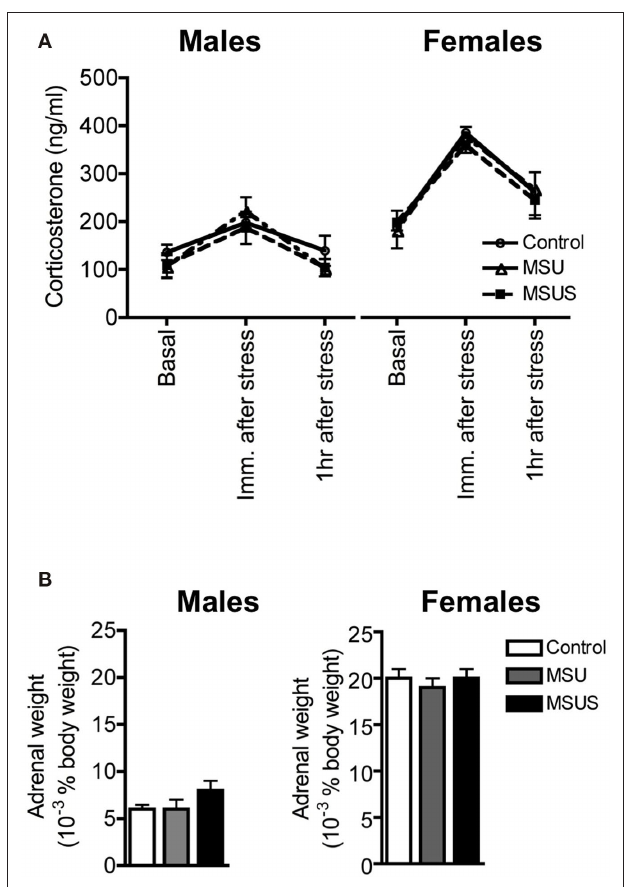
FigUrE 7 | Assessment of markers of the HPA axis in F 1 control, MSU, and MSUS mice. (A) All groups had a comparable titer of corticosterone in plasma 1 week before, immediately after, and 1 h after a 20-min restraint stress (all measures were performed in the same animals across treatment). Males: MSU, n = 4, MSUS, n = 4, control, n = 6; females, MSU, n = 4, MSUS, n = 9, control, n = 5. (B) Similar adrenal weight in all mice. Males MSU, n = 6, MSUS, n = 8, control, n = 8; females: MSU, n = 7, MSUS, n = 8, control, n = 7. Bar graphs represent mean values ±